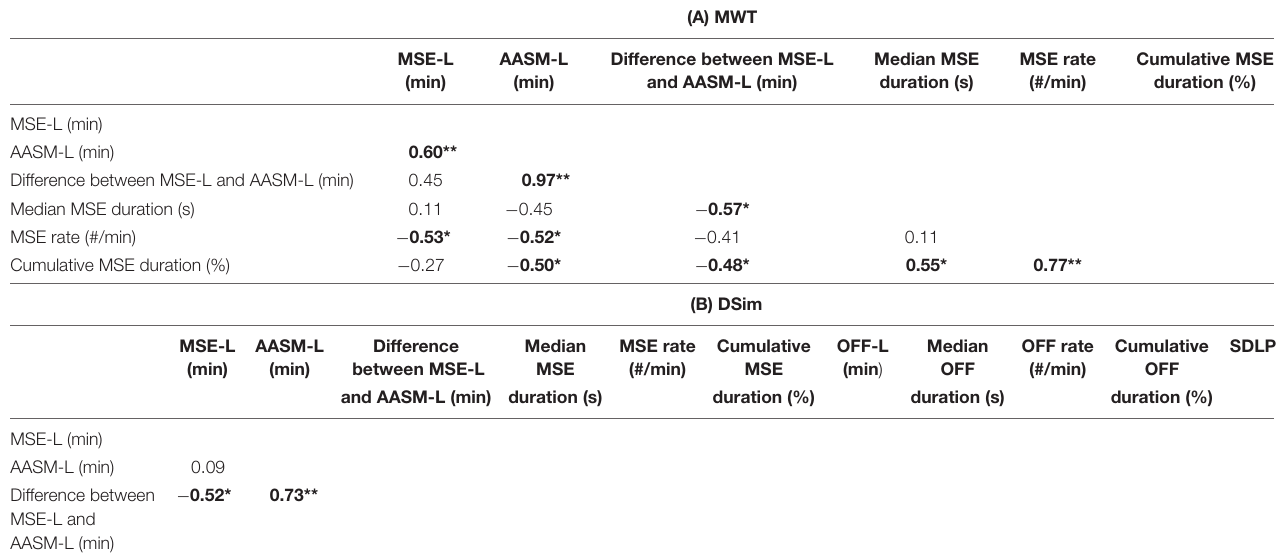
TABLE 3 | Correlation coefficients (Spearman’s rank) for sleepiness and driving performance measures after sleep deprivation are reported: (A) maintenance of wakefulness test (MWT), (B) driving simulator (DSim), and (C) between the MWT and the